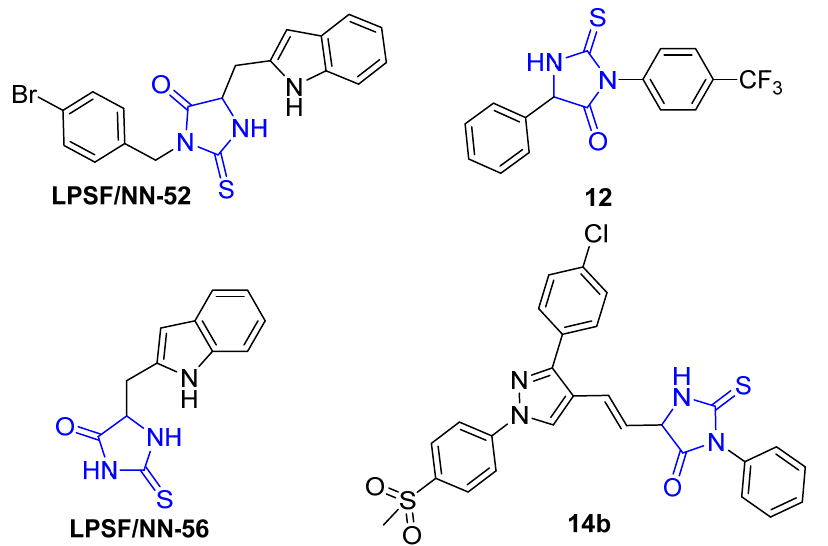
Figure 3. Selected 2-thioxoimidazolidin-4-one analogues with potent anti-inflammatory activity.